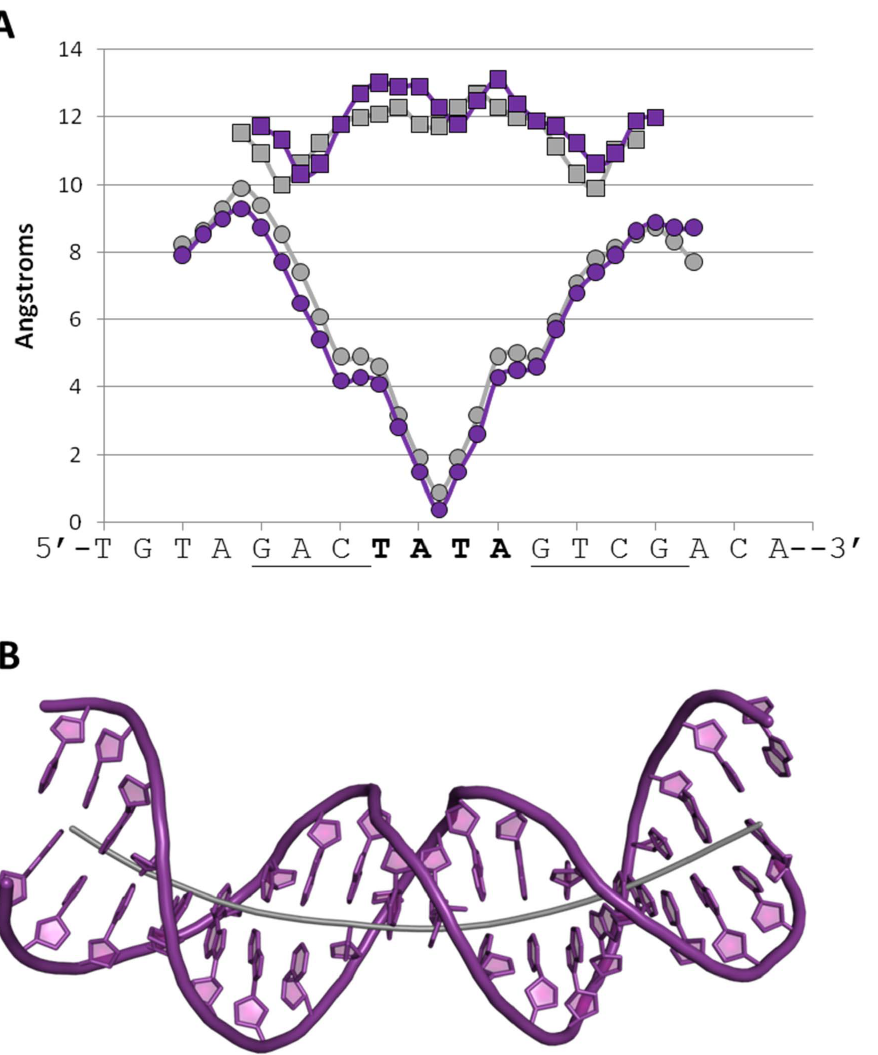
Figure 8. DNA bending analysis of the DNA from the C.Esp1396I-Y37F-19O M co-crystal structure. (A) Groove width analysis of the DNA in the Y37F-19O M crystal structure. The wild-type 19O M co-crystal structure is shown in grey and the Y37F mutant co-crystal structure in purple. Major grooves widths are shown with squares and minor groove widths with circles. (B) The DNA duplex from the Y47F-19O M co-crystal structure shown with the helical axis in grey. Analysis performed using the Curves + server